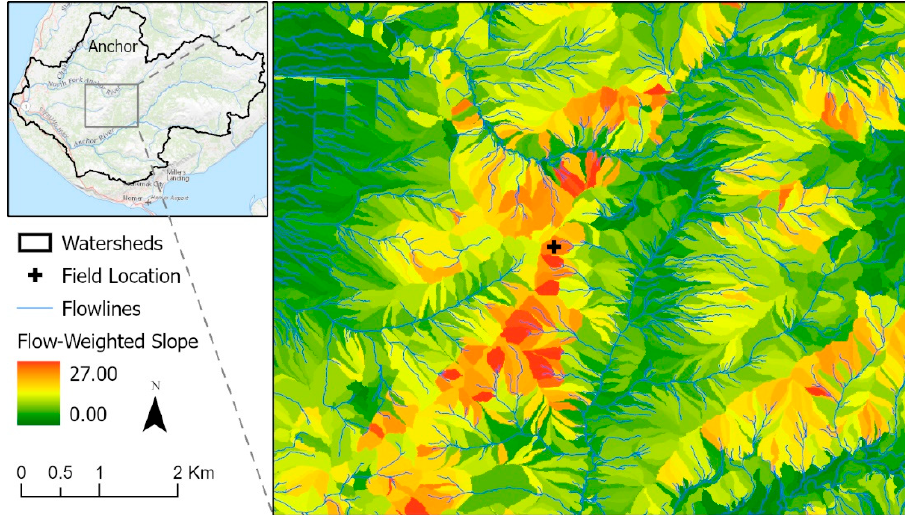
Figure 4. Example of implementing the two-step workflow to locate hillslope groundwater dis- charge. FWS is first used to identify hillslopes with relatively high FWS. Flowlines are then used to identify specific locations where channels may initiate. Diffuse seeps are commonly found in these settings, including at the field location in this example.